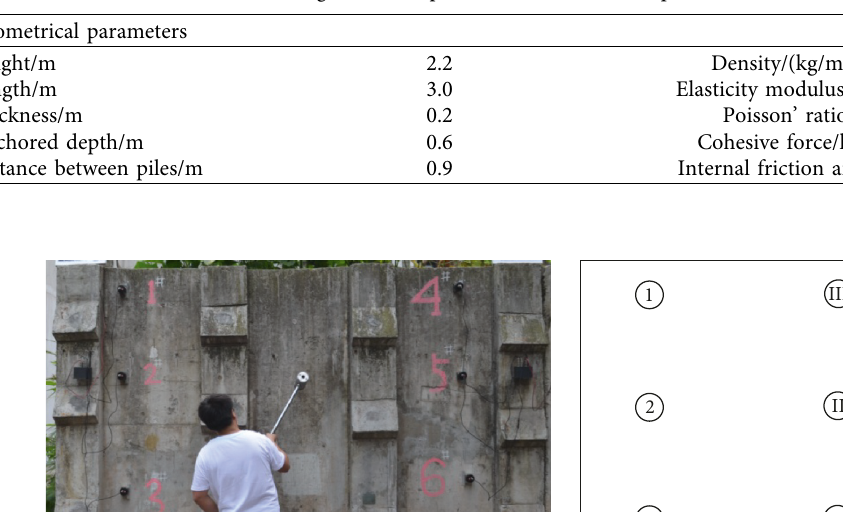
Table 1: The geometrical parameters and material parameters of the wind-break